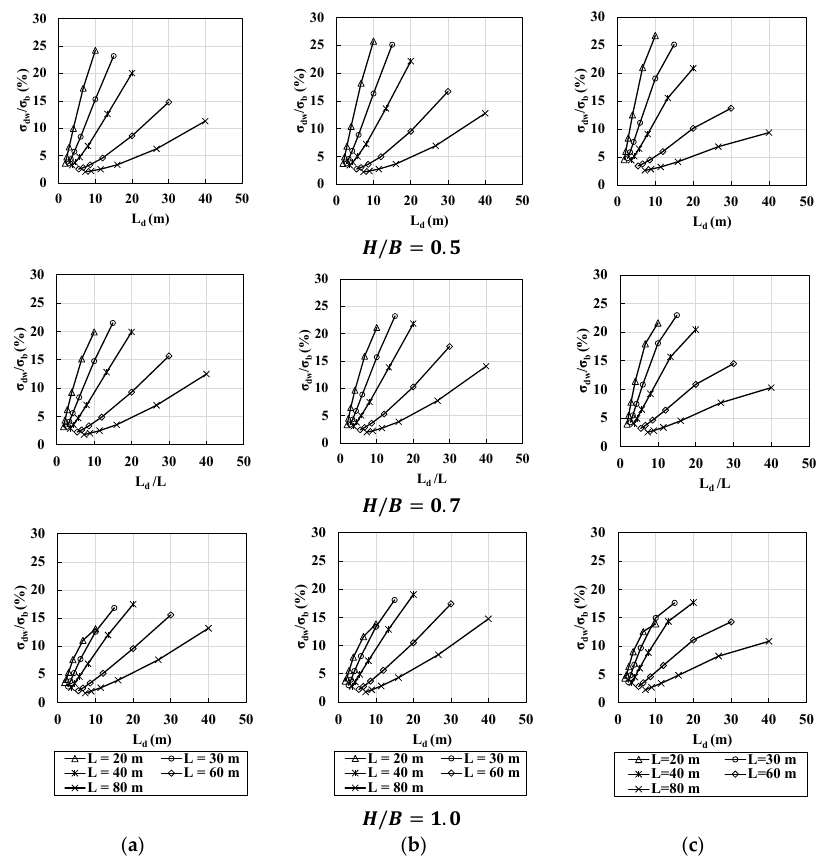
Figure 8. Normal stress ratio based on the intermediate diaphragm spacing ( 𝐿 (cid:3031) ) and span length ( 𝐿 ). ( a ) LC1, ( b ) LC2, and ( c ) LC3.